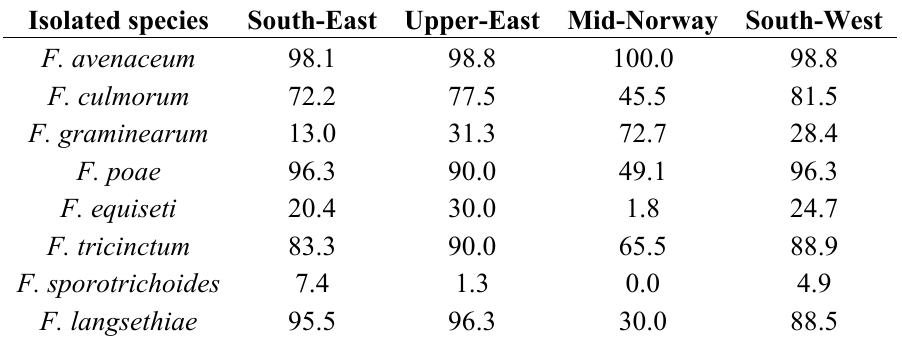
Table 5. Occurrence (%) of Fusarium spp. isolated from oat samples from four regions in Norway from 1994 to 1996, as determined by Kosiak et al.